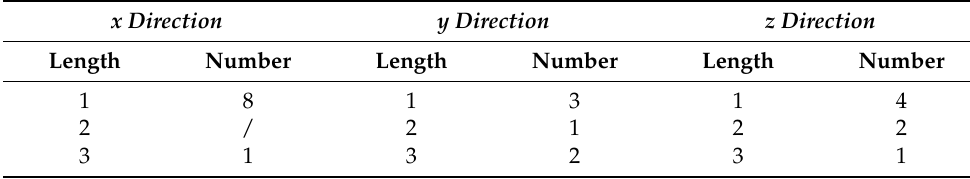
Table 1. Number of segments in the three spatial